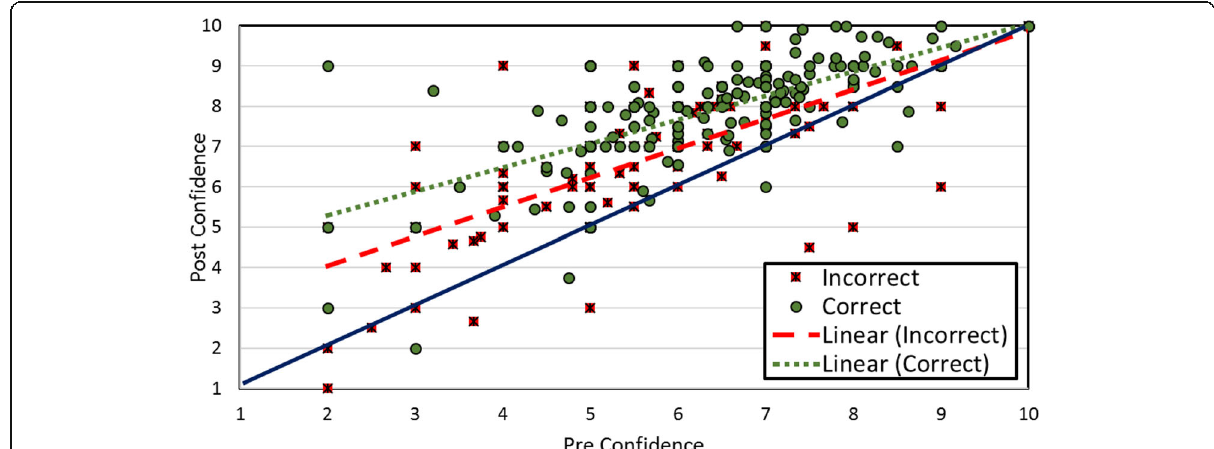
Fig. 4 The relationship between pre-discussion and post-discussion confidence as a function of the accuracy of an answer when partners agreed. Each dot represents a